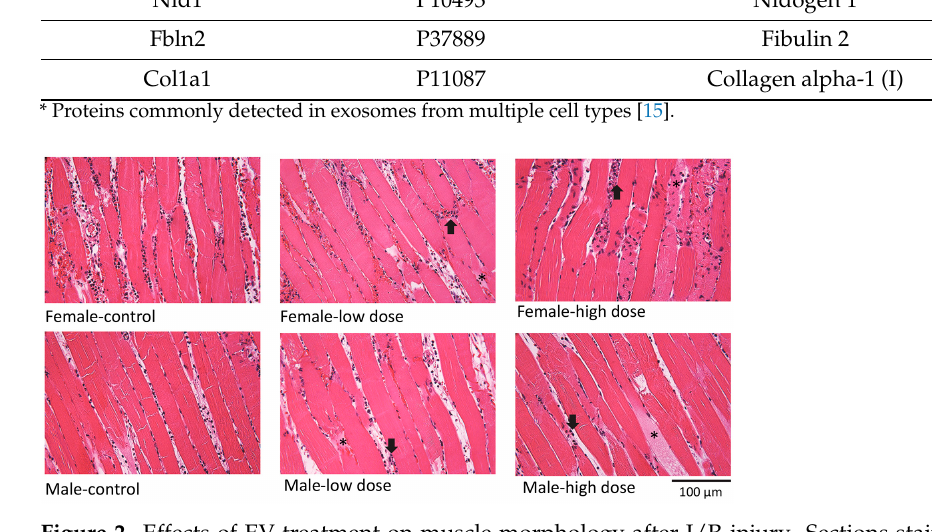
Table 2. ANOVA results from parameters examined in mice treated with vehicle or low-dose (50 ug) extracellular vesicles.